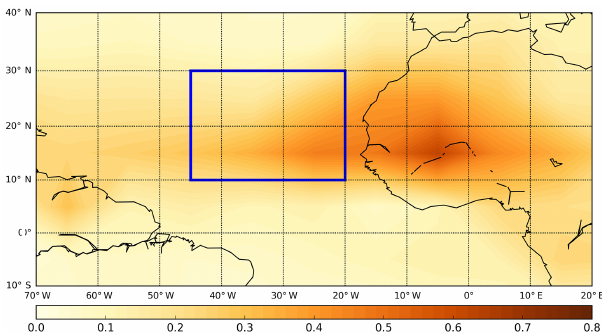
Figure 1. CALIPSO-derived seasonal mean (JJA) dust aerosol opti- cal depth (AOD) at 0.5µm averaged over five summers (2007–2010) in cloud-free sky conditions from the integrated CALIPSO, Cloud- Sat, CERES, and MODIS merged product (CCCM). Figure 2. Size distributions of mineral dust used in this study.